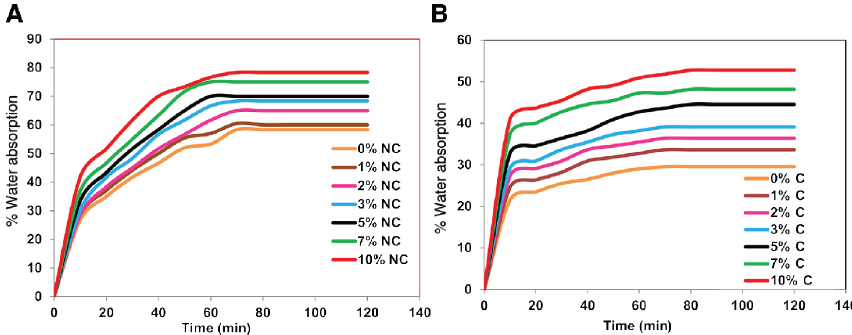
Figure 3: Water absorption for (A) non-coated and (B) coated